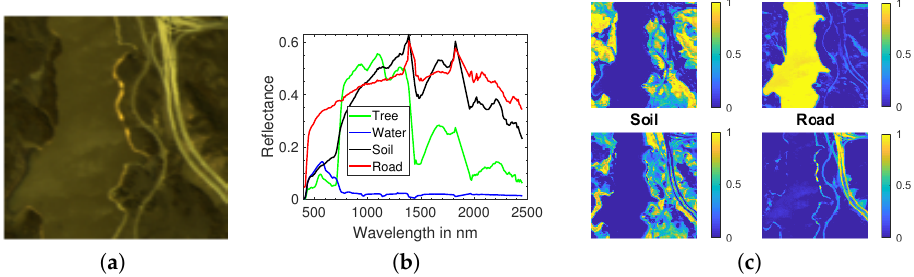
Figure 3. Jasper Ridge image. ( a ): True-color image (red: 570.14 nm, green: 532.11 nm, blue: 427.53 nm); ( b ): endmembers; ( c ): abundance